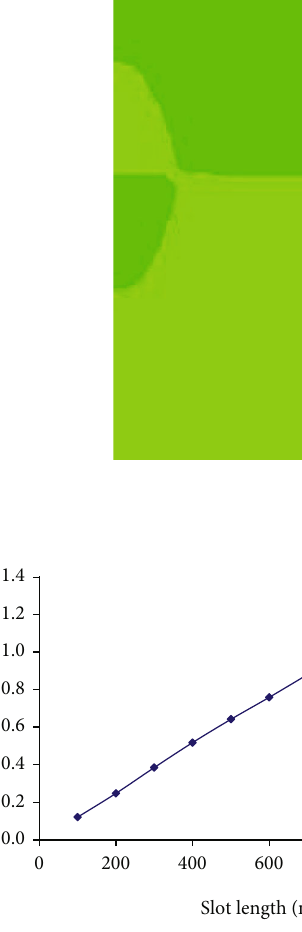
Figure 6: Relation between slot length and normal displacement.